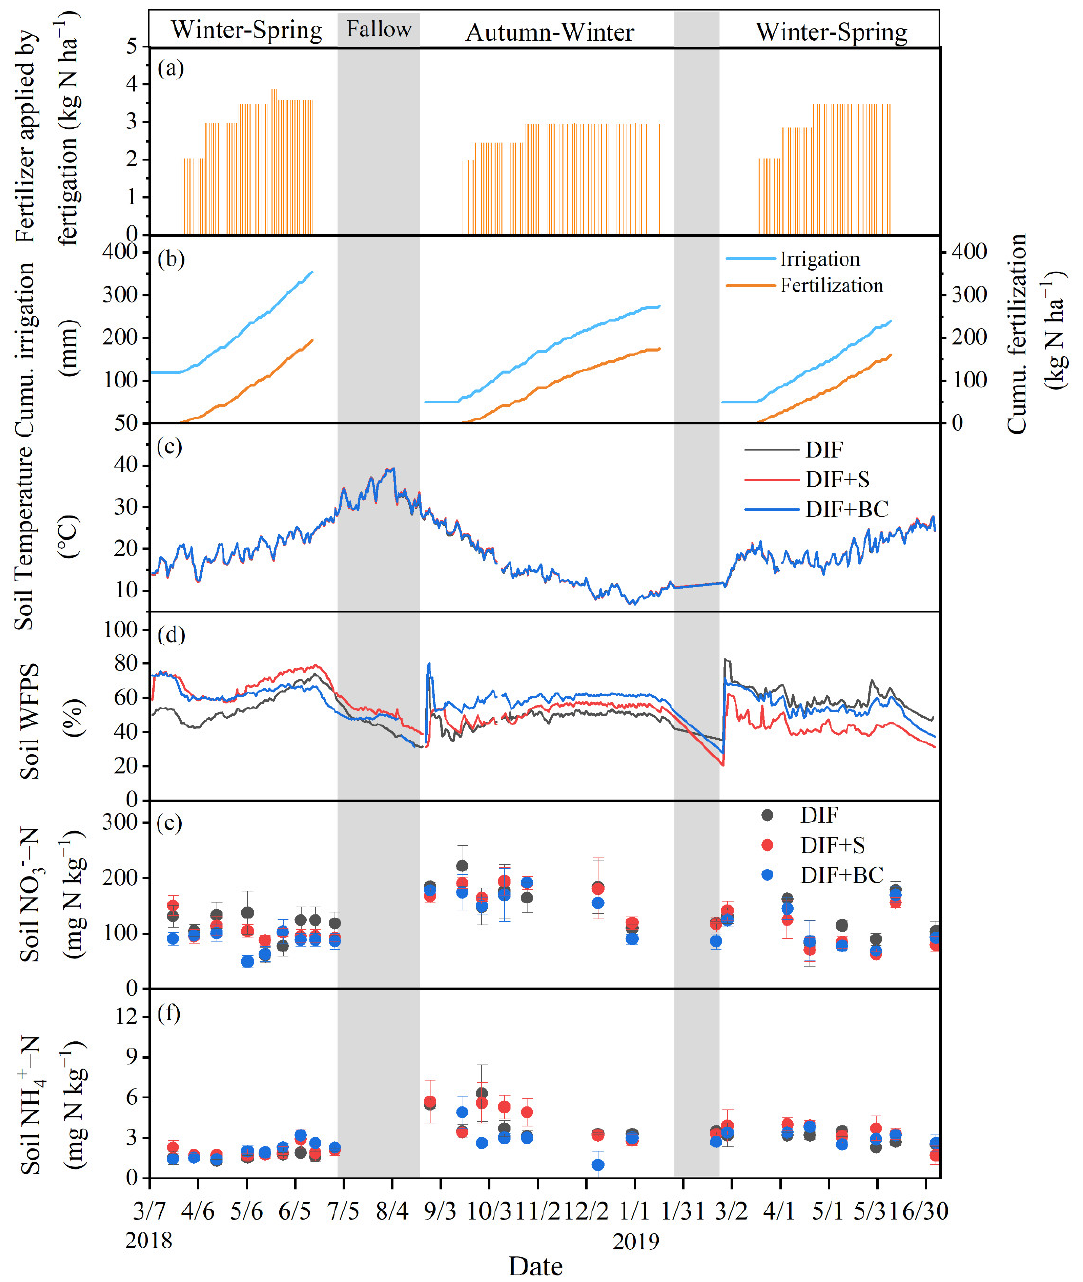
Figure 1. Temporal dynamics of daily fertigation (i.e., synthetic fertilizers applied with irrigation water) ( a ), cumulative amount of irrigation and fertilization ( b ), soil temperature ( c ) and soil water- filled pore space (WFPS, 0–12 cm soil depth) ( d ) and soil inorganic N concentrations in 0–30 cm soil depth (( e ): NO 3 − -N concentration; ( f ): NH 4+ -N concentration) for the three growing seasons, for which information on soil N 2 O fluxes (Figure 3) is also available. Different colors in panels ( c – f ) refer to different treatments, including black: drip fertigation (DIF); red: drip fertigation with straw incorporation (DIF+S); blue: drip fertigation with biochar incorporation (DIF+BC). SDW represents soil dry weight. Error bars represent the standard error ( n = 3).